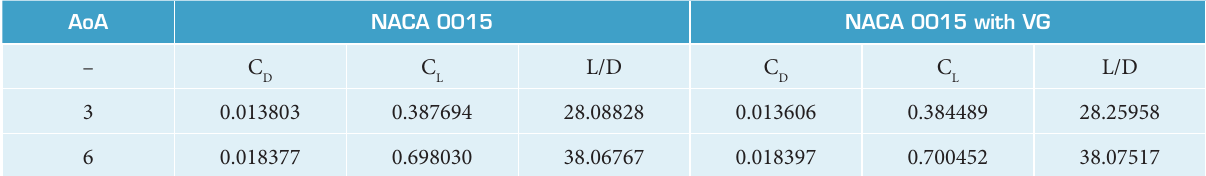
Table 1. Comparison between lift and drag between the wing with and without VG.